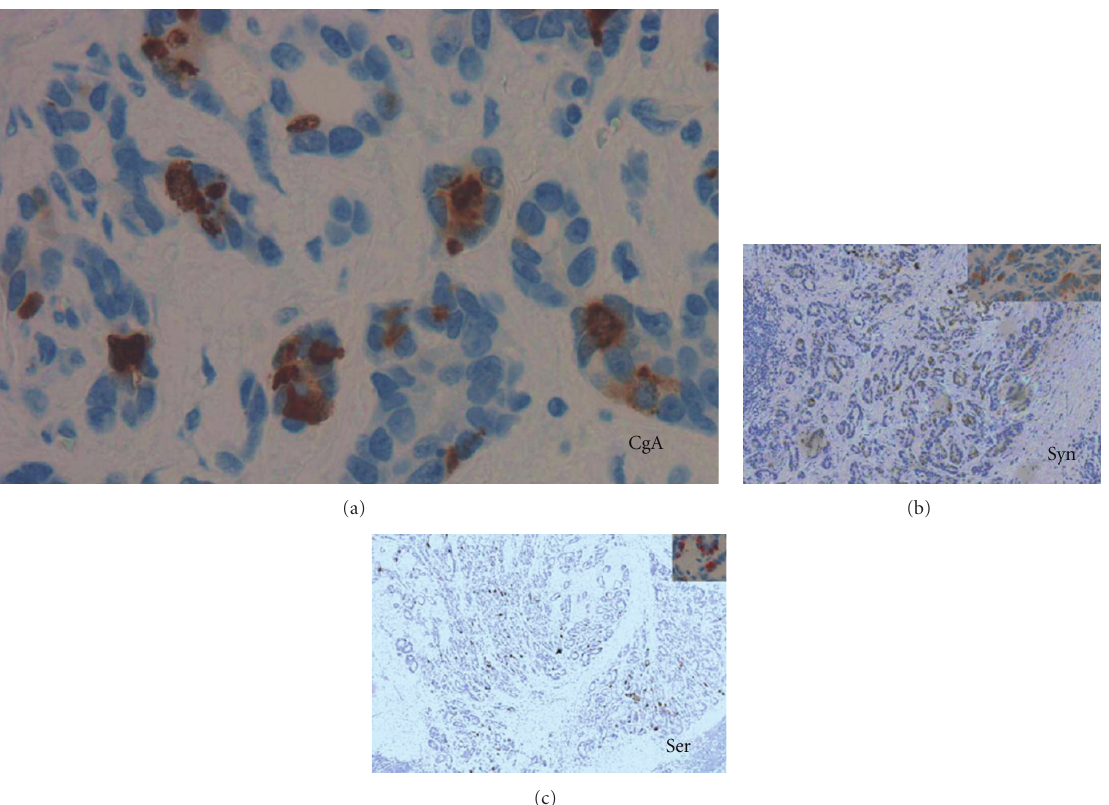
Figure 1: 1 Immunohistochemical labelling of tumour cells in the gastric cardiac region in patient 4. Tumour cells label positive for CgA (40x) (a), synaptophysin (b), and serotonin (c) 20x. Inserts